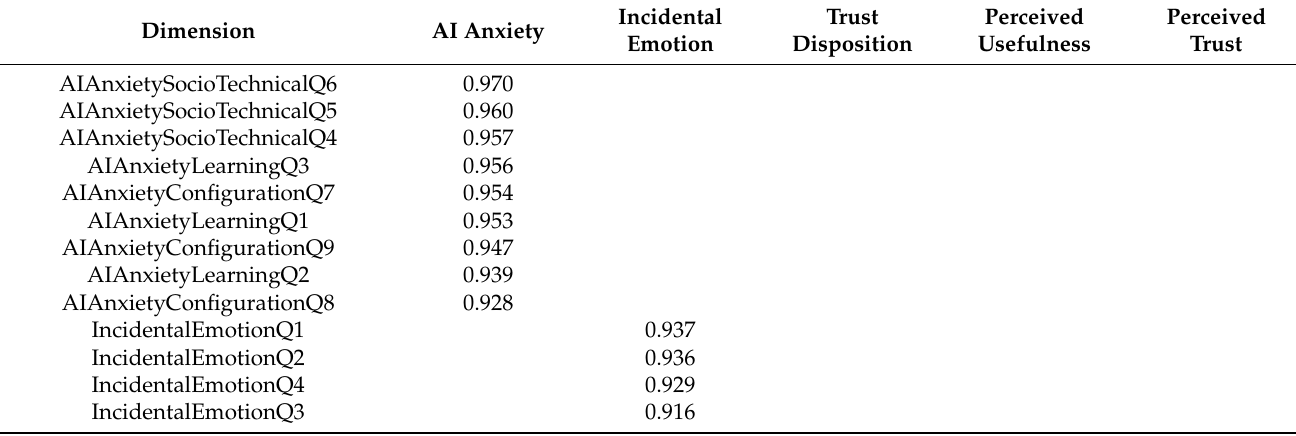
Table 4. Rotated component